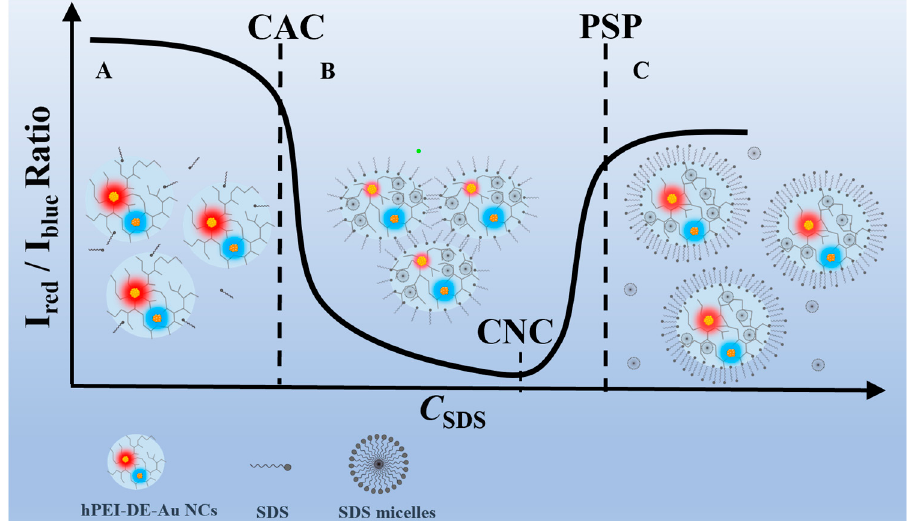
Figure 1. Schematic illustration of hPEI-SDS interaction visualization by DE-AuNC labeling. hPEI- DE-Au NCs interacting with 0-1.6 mM SDS ( A ), 1.6-8mM ( B ), and 8-10 mM ( C ).